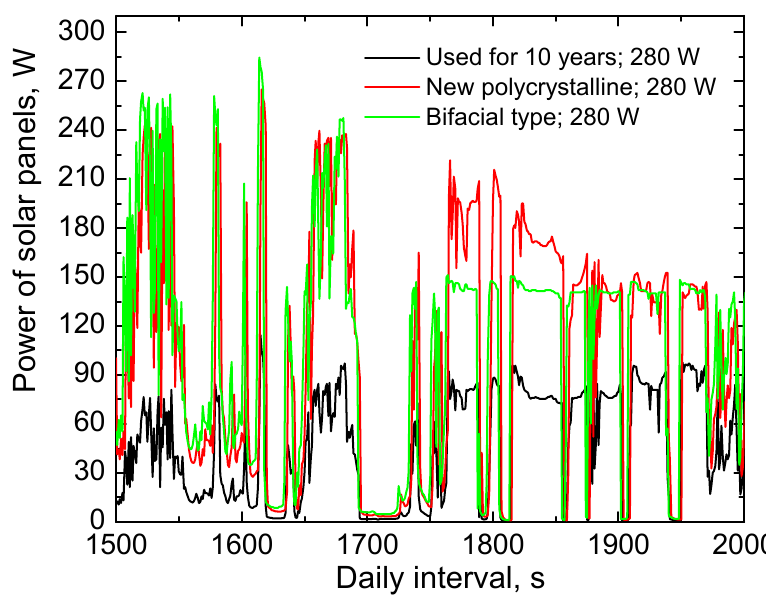
Figure 9. Variation of solar battery power during the sunrise–sunset interval.